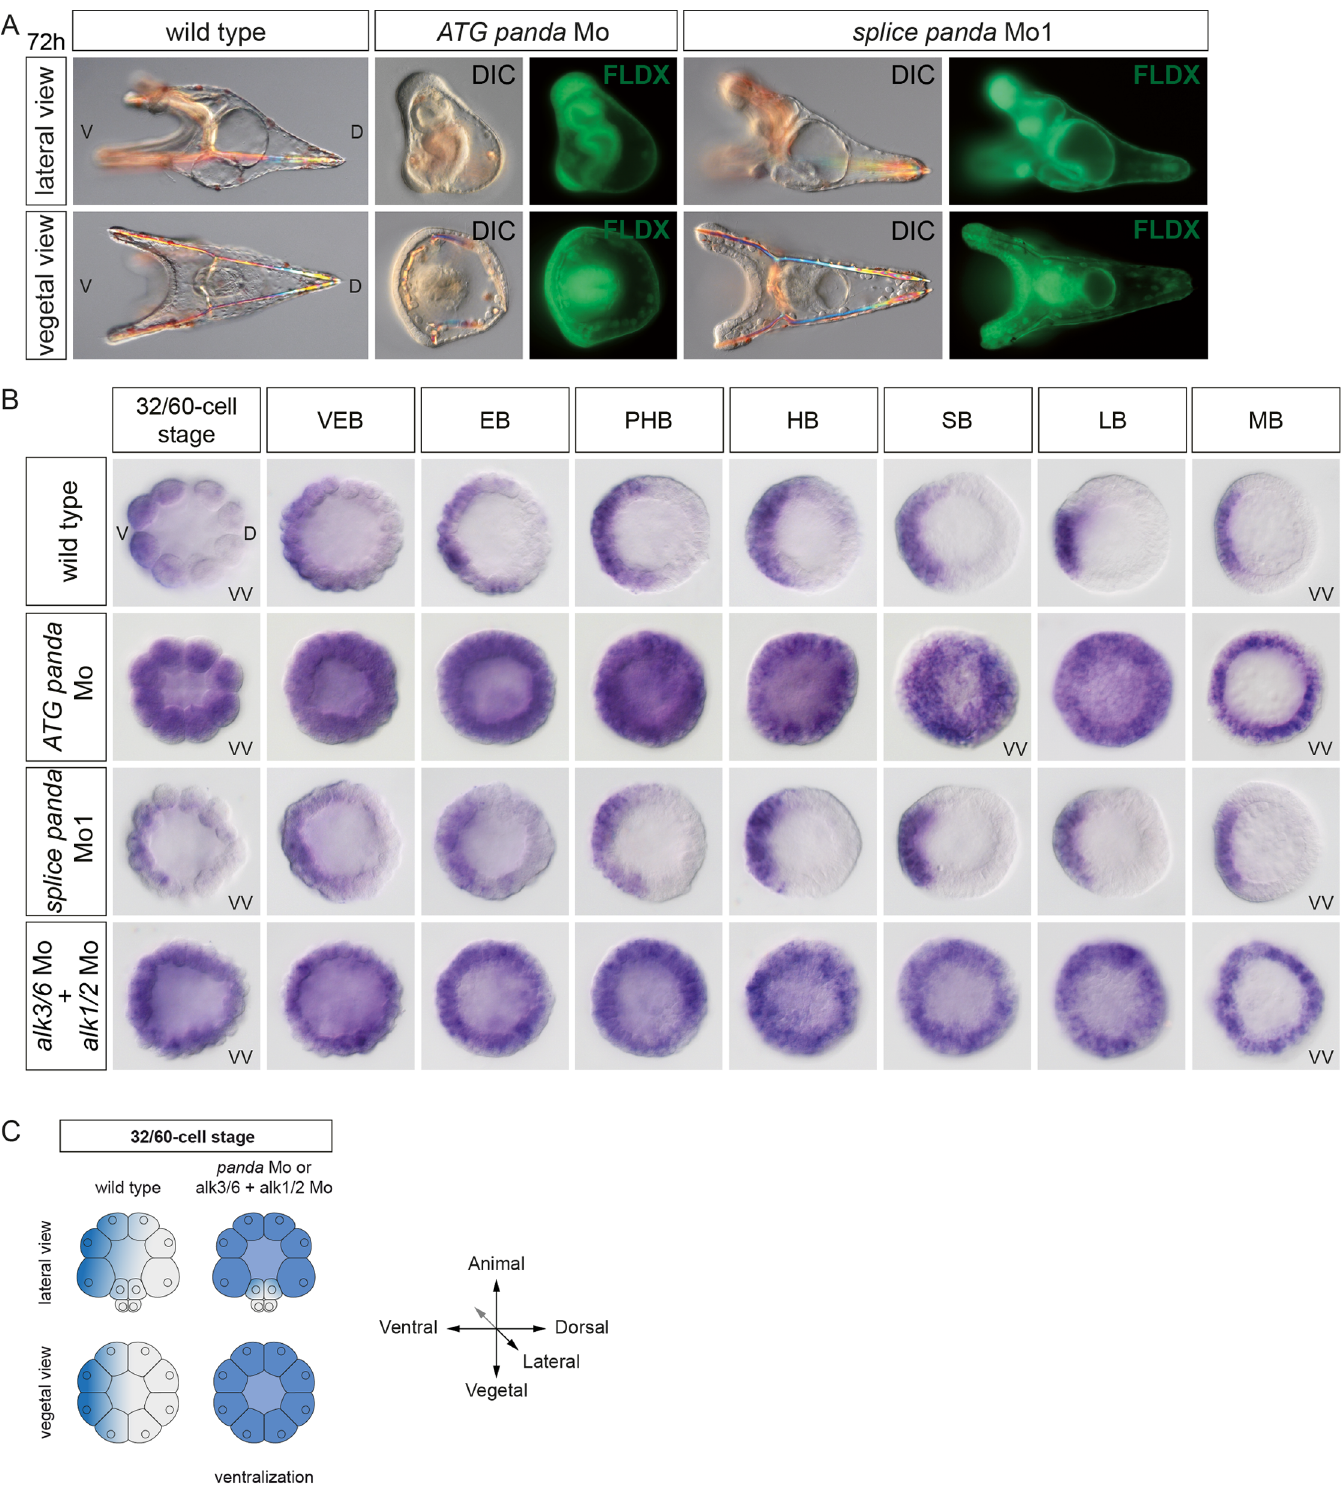
Fig 7. Maternal but not zygotic Panda function is required for the spatial restriction of nodal expression. (A) Injection of a morpholino oligonucleotide targeting the translation start site of panda mRNA, but not of a morpholino targeting a splice junction, disrupts the establishment of D/V polarity. The lineage tracer Fluoresceinated Lysine-Fixable Dextran (FLDX) was coinjected with the morpholino. (B) In situ hybridizations against the nodal transcript at early stages. In the absence of maternal, but not of zygotic, Panda, a massive ectopic expression of nodal is observed starting at the 60-cell stage. Note that